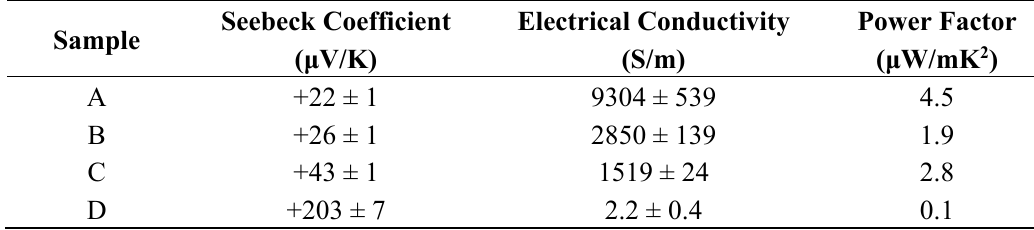
Figure 3. Seebeck measurement plots of sample pellets synthesized with Cu:Fe metallic feeding ratios of ( A ) 100:0; ( B ) 70:30; ( C ) 50:50; and ( D ) 30:70. Table 2. Seebeck coefficients, electrical conductivity and power